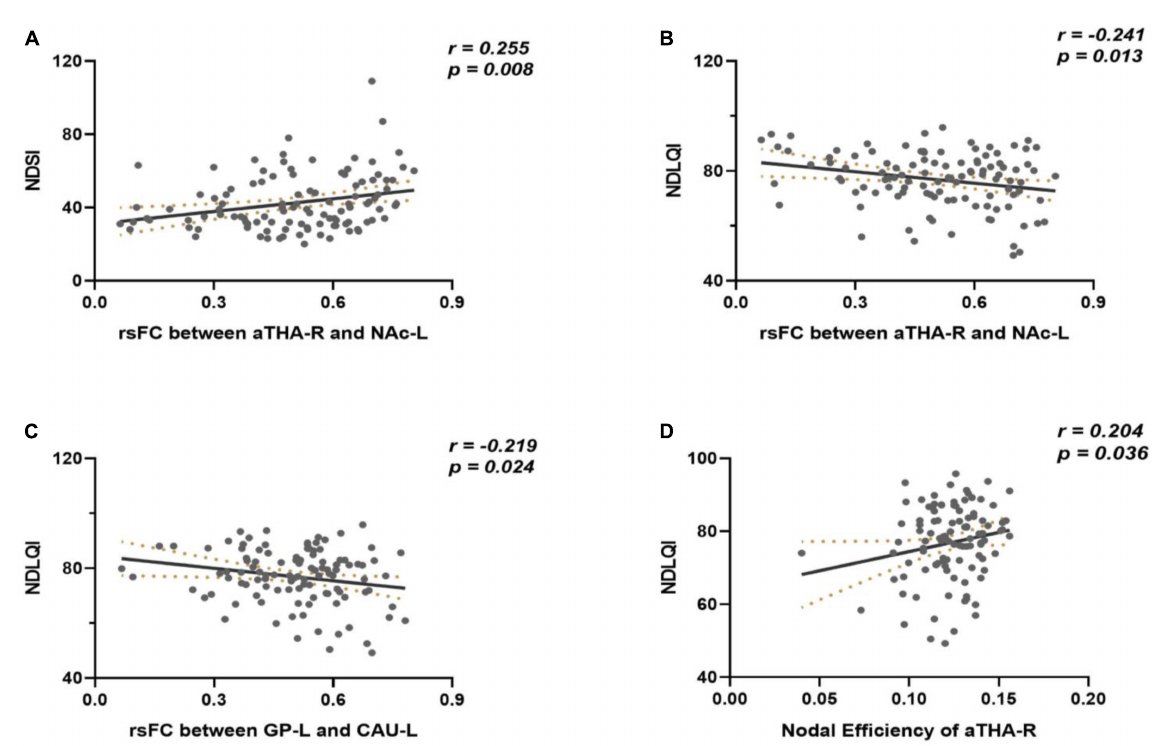
FIGURE4 Results of correlation analyses. (A) the rsFC of the aTHA_RNAC_L edge was positively correlated with the NDSI; (B,C) the rsFC of the aTHA_R-NAc_L edge and GP_L-CAU_L edge were negatively correlated with the NDLQI; (D) the nodal efficiency of aTHA_R was positively correlated with the